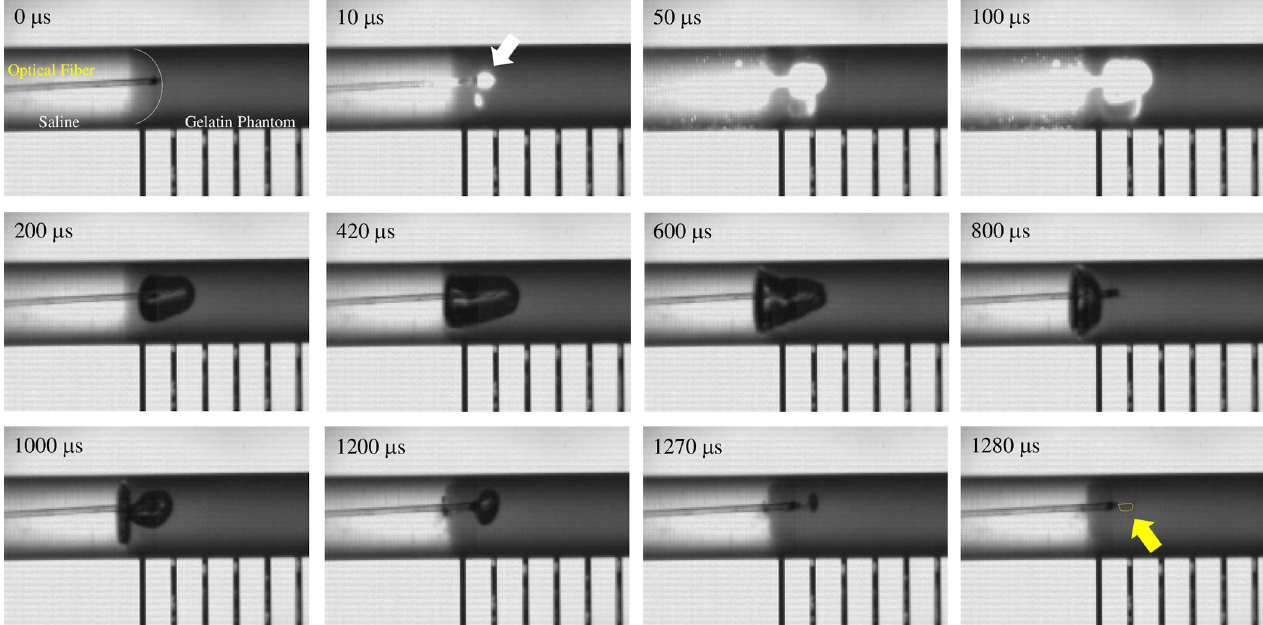
Fig 3. Typical example of a bubble generated by one pulsed laser irradiation in a gelatin phantom (incidence energy: 16 mJ/pulse, pulse width: 100 μ s, frame rate: 10 μ s/f, exposure time: 2 μ s). A bubble (white arrow) in the gelatin phantom was generated within 10 μ s after the irradiation onset and grew over time. The inner wall of the growing bubble was irradiated with pulsed light for 100 µ s. The pulsed light was scattered and reflected within the bubble. The bubbles continued to grow even after the pulsed light irradiation ended, reaching a maximum size (long-axis direction: 2.53 mm, short-axis direction: 1.35 mm) after 420 µ s. At 1280 μ s, the bubble disappeared and cutting marks were observed in the gelatin (yellow arrow). No bubble bursts were